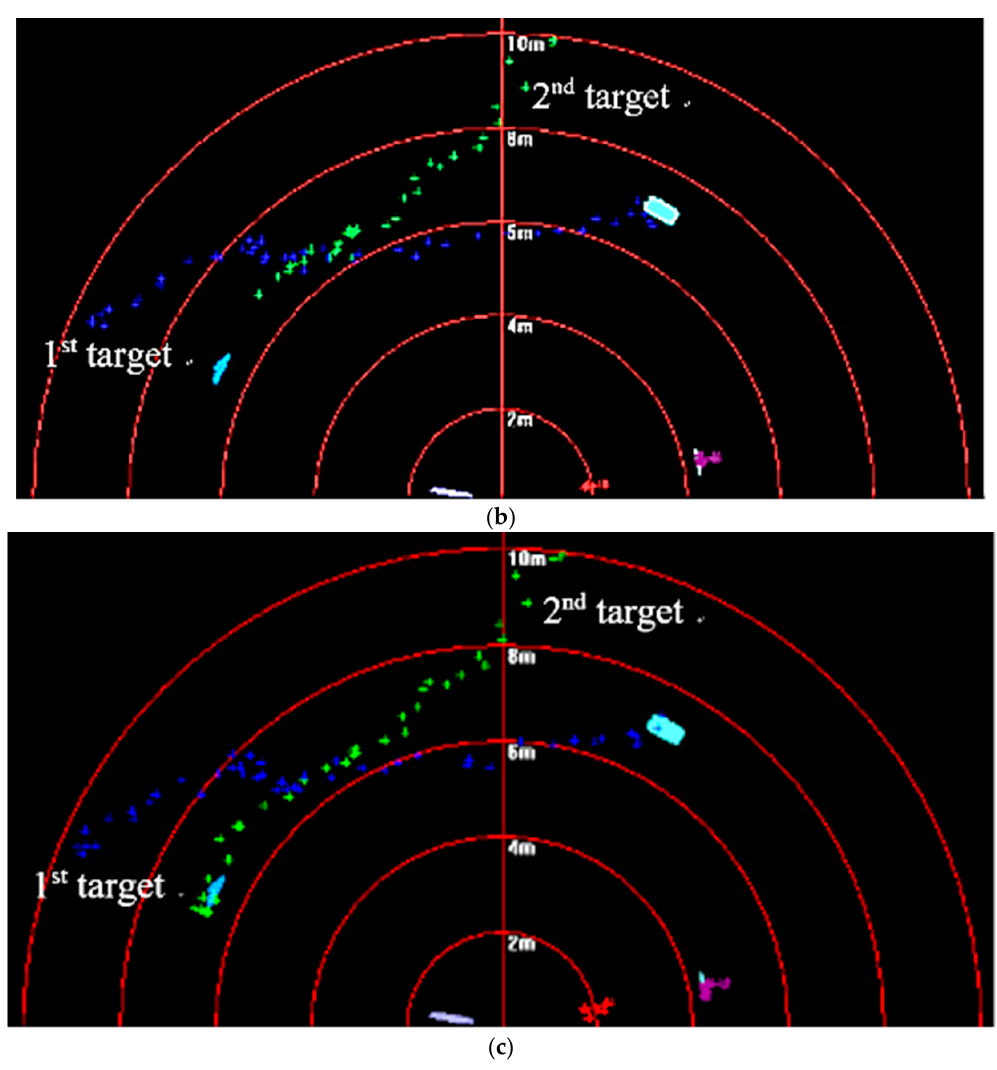
Figure 17. Tracking results based on different fusion strategies gained by ( a ) MF; ( b ) WF; and ( c ) proposed method.